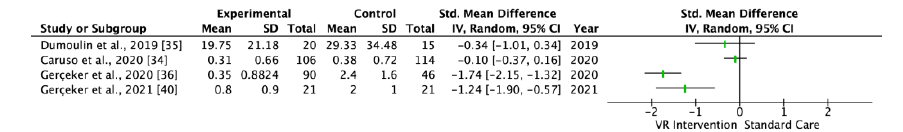
Figure 5. Comparison of VR treatment and standard care, fear. SD: standard deviation; 95% CI: 95% confidence interval. Without pooling due to heterogeneity (I 2 = 94%).